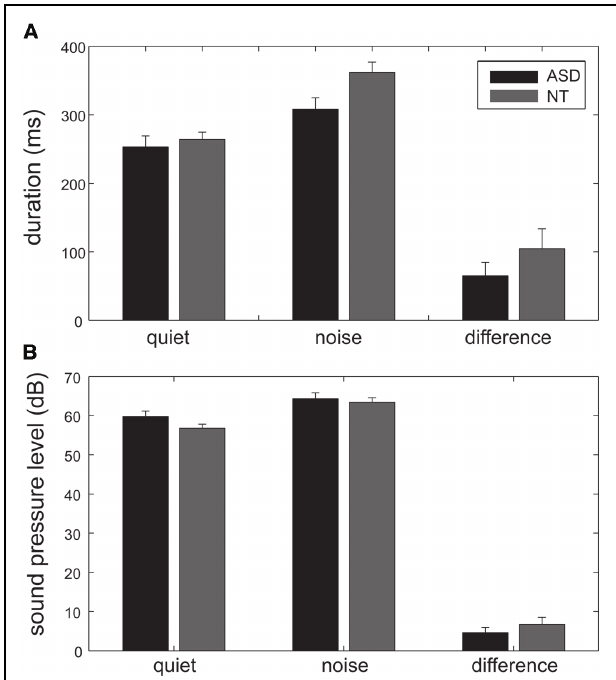
FIGURE 2 | The phonation duration and the sound pressure level measured for the quiet and noisy conditions in the two groups. When the participants’ own speech was sent back to them with background noise, both their phonation duration (A) and sound pressure level (B) increased, indicated as mean ± standard error. The Lombard effect, which was the increase in phonation duration and sound pressure level for the noisy condition (the rightmost bars), was significantly smaller in the ASD group (black bars) than in the control group (gray bars).